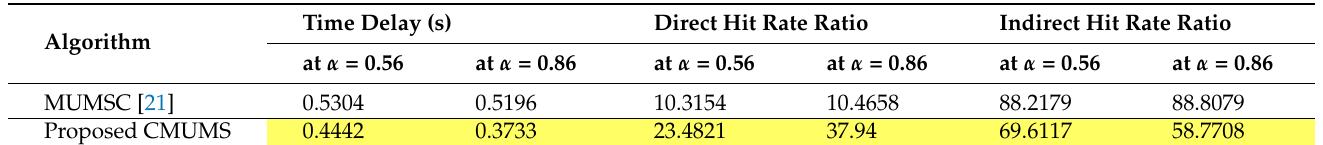
Figure 16. Heatmap represents direct hitrate vs. caching max Memory per each server for the CMUMS caching algorithm at different α . Table 6. Summary of our proposed CMUMS model